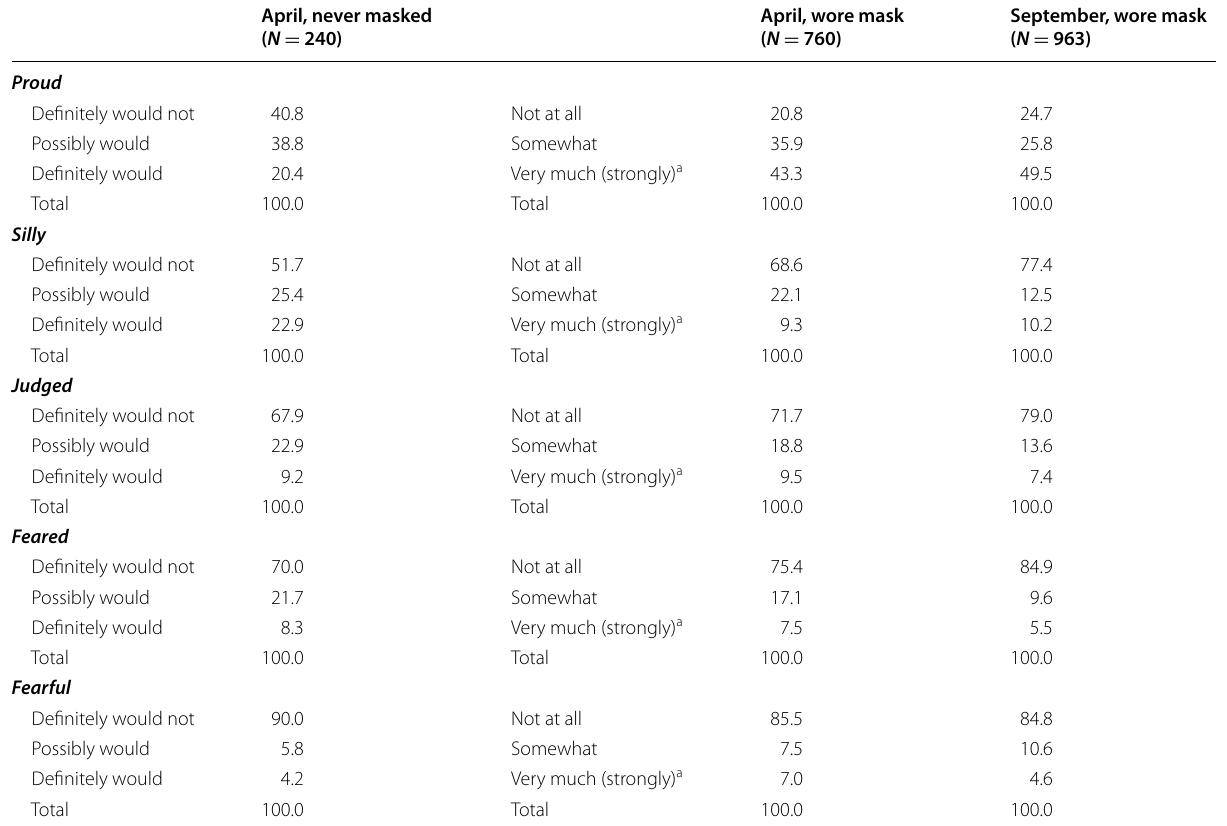
Table 1 Distributions of SAMI items, by phase (column percentages)